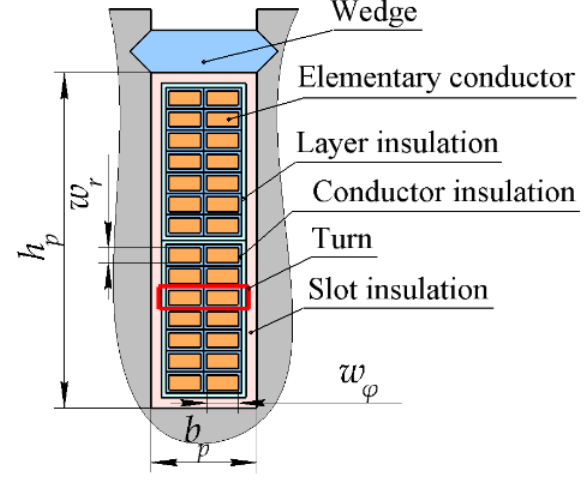
Figure 2. Open type stator slot sketch.